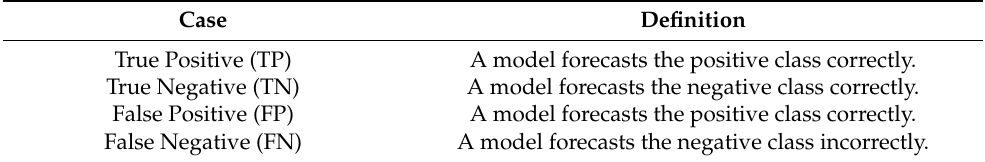
Table 2. Four cases concerning the prediction.